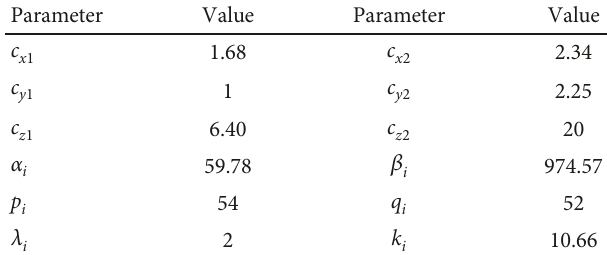
Table 3: Control system